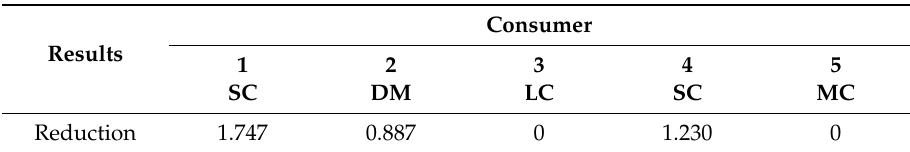
Table 7. Optimization Results.